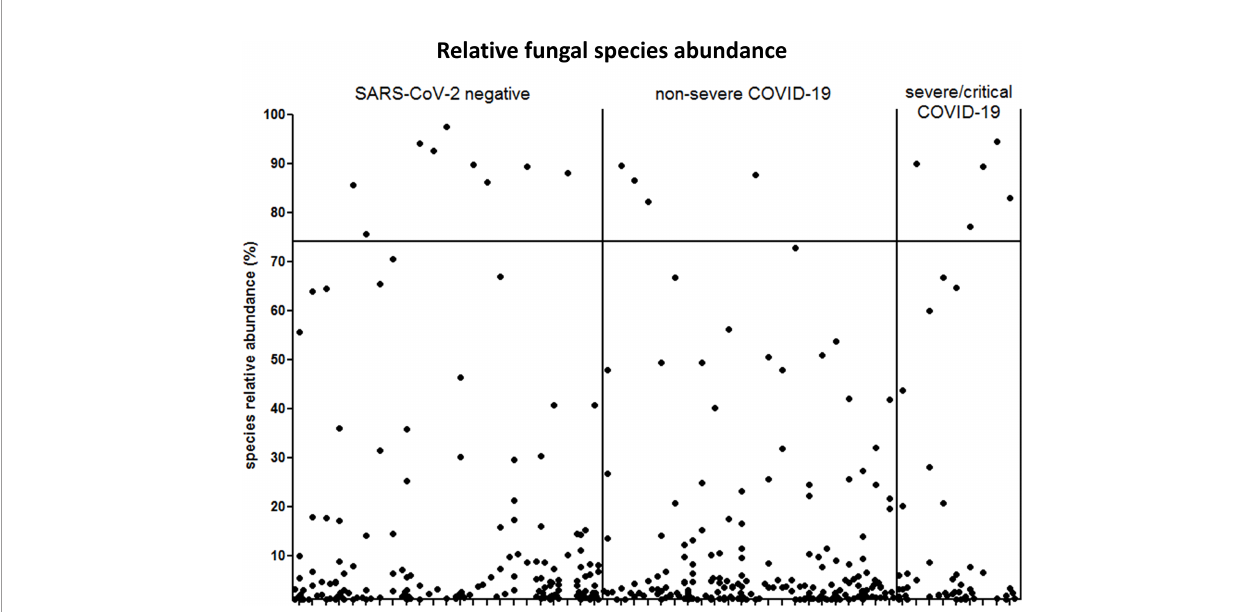
FIGURE 3 | Relative abundance of individual fungal species SARS-CoV-2 negative patients and patients with non-severe and severe/critical COVID-19. Each dot represents one species. The samples of the individual patients are arrayed along the x-axis and the relative abundance of each species is illustrated on the y-axis. Species that account for at least 1% relative abundance are included. The horizontal bar indicates the 75% threshold.